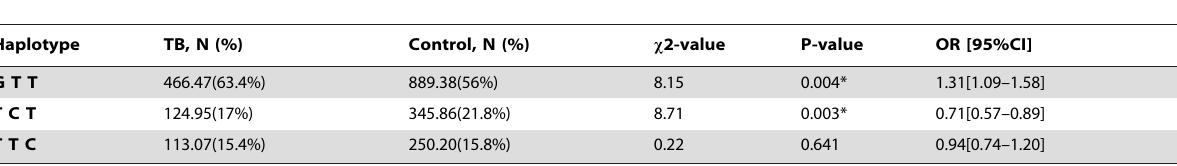
Table 3. Haplotypes carried out using rs3888188, rs6598045, and rs7478728 by SHEsis.